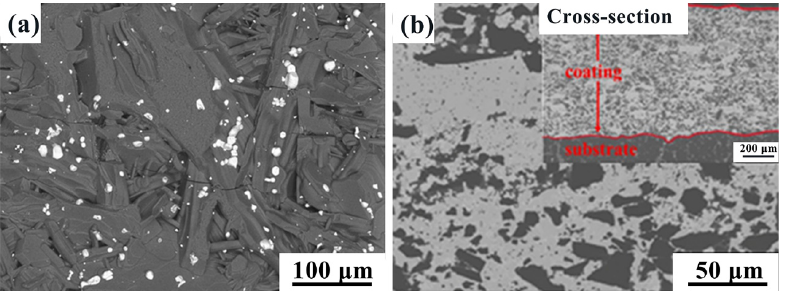
Fig. 32 Typical morphologies of the UHTC–silicide coatings: PC–ZrB 2 –SiC coating [296] (a) and SPS–HfB 2 –SiC–TaSi 2 coating [320] (b). Reproduced with permission from Ref. [296], © Elsevier Ltd. 2018; Ref. [320], © Elsevier Ltd.